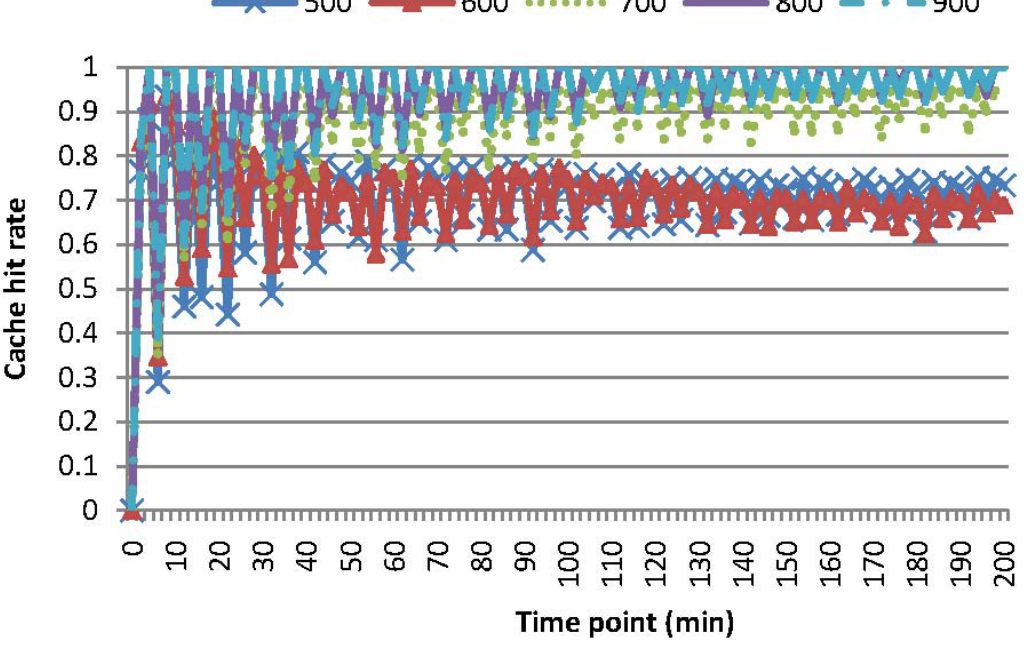
Figure 9. Comparison of cache hit rates for MAQWR, where the cache size of the SN is set to 500 , 600 , 700 , 800 and 900 , respectively. Similar to Figure 8, when the cache size of the SN is relatively small and is not capable of caching all sensory data requested by a certain query, the cache hit rates for sensory data cached in the SN decrease significantly (roughly from 95% down to